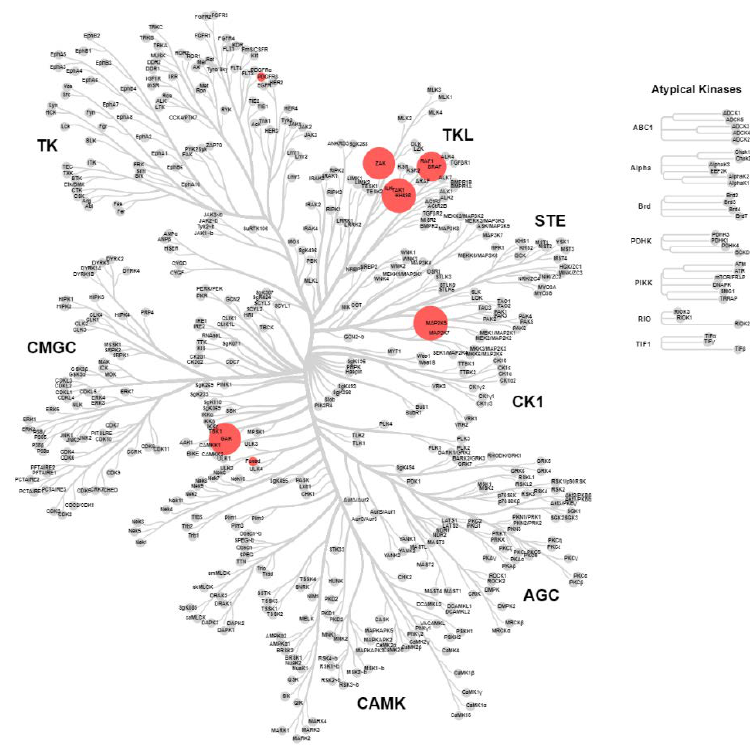
Figure 2. Representation of the human kinome based on sequence identity displaying KINOMEscan ® results for compound 7 screened at 1 µM. Red dots represent kinases inhibited by >80%, differentiated by size; wild-type human kinases inhibited >80% at 1 µM MEK5, 100%; STK36, 94%; ZAK, 93%; GAK, 92%; PDFRB, 91%; BRAF 84% and TNNi3K, IC 50 = 25 nM [10] (see Supplementary Materials).